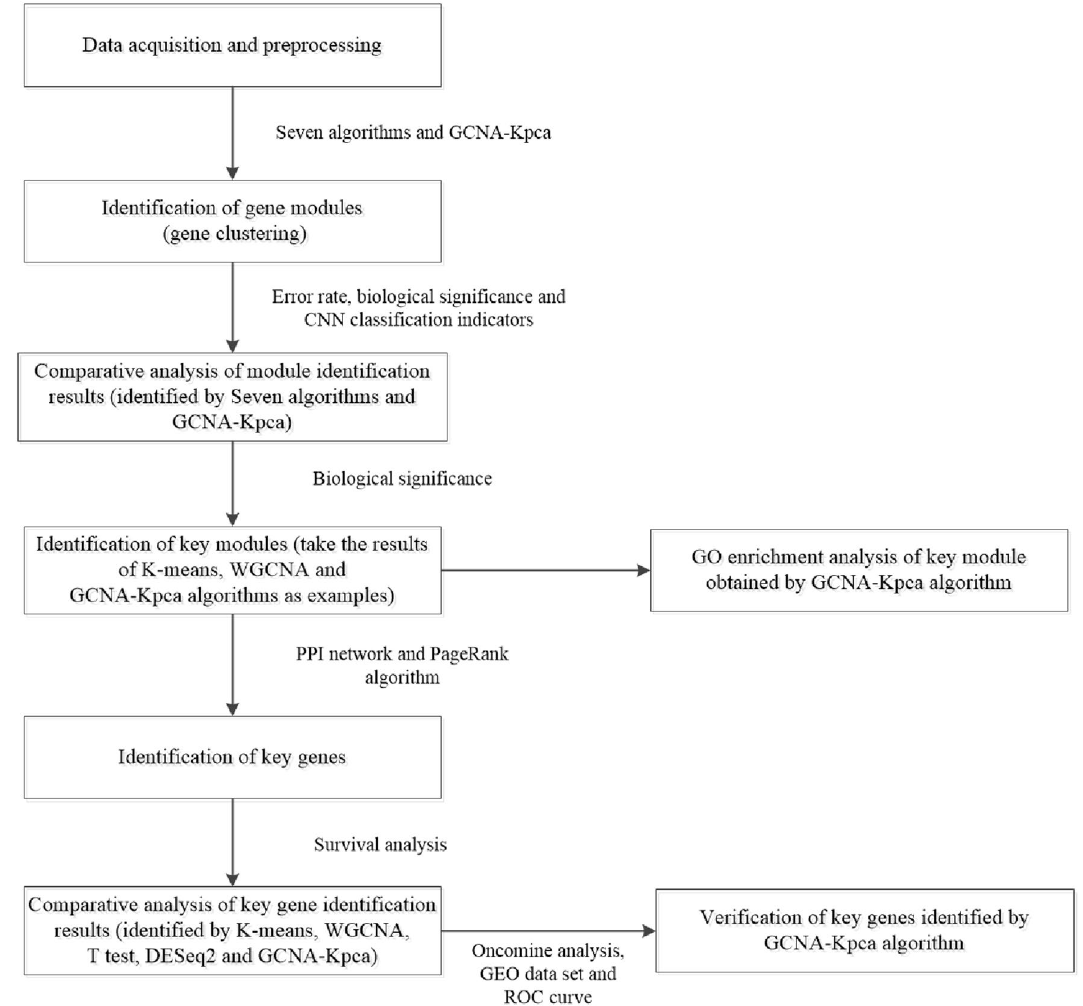
Figure 1. Flow-chart of data analysis in this paper. This figure was drawn with Microsoft Visio 2010.